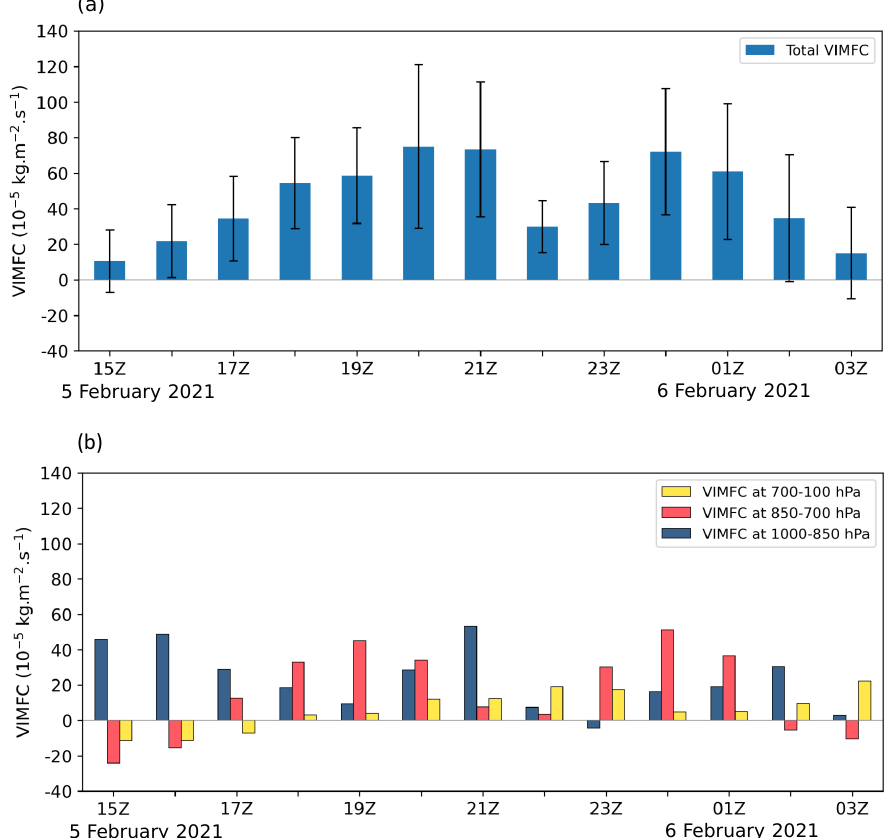
Figure 6. Hourly time evolution of the vertically integrated moisture flux convergence (VIMFC, 10 − 5 kg.m − 2 .s − 1 ) over the Greater Semarang area (6.625 ◦ S–7.125 ◦ S and 110.125 ◦ E–110.625 ◦ E) calculated for ( a ) the total atmospheric columns with its standard deviation, and ( b ) the three layers defined in the study; that is, upper-layer (100 < p < 700) hPa; middle-layer (700 ≤ p < 850) hPa; and bottom-layer (850 ≤ p ≤ 1000) hPa during 15Z 5 February 2021 to 03Z 6 February